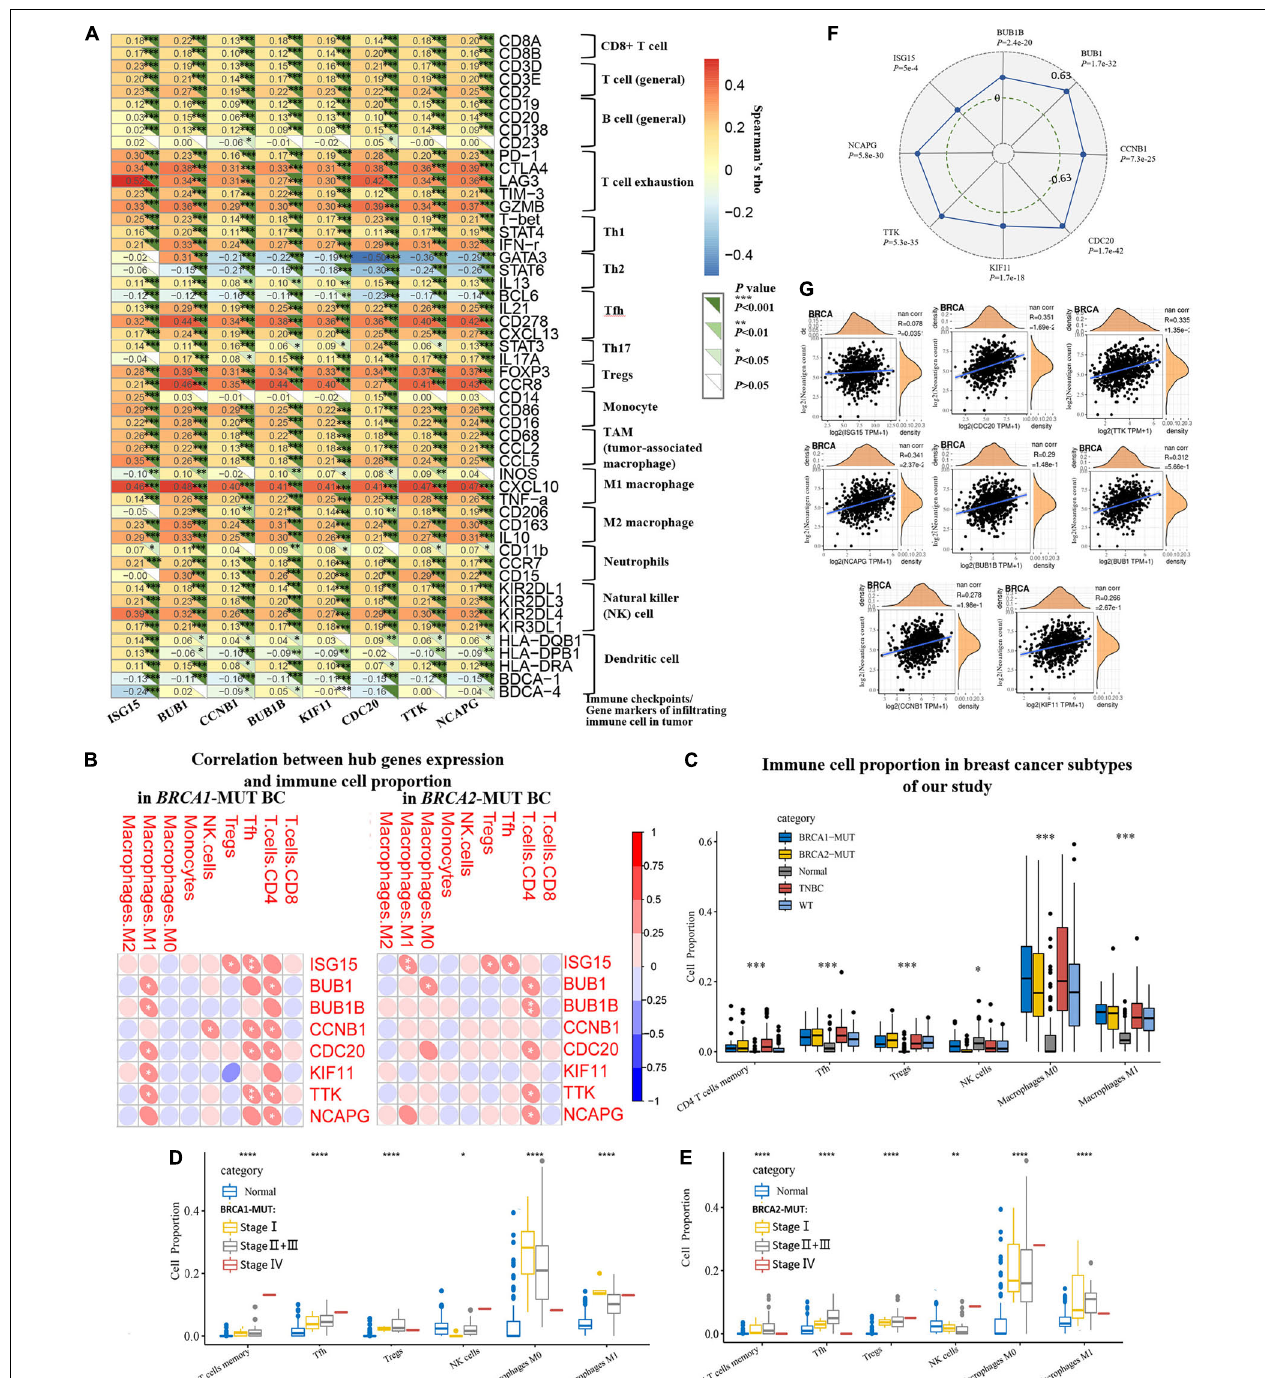
FIGURE 8 | Analysis and identification of BRCA1/2 -MUT-specific immune-associated patterns and their relationships with TMB and neoantigen load in BC. (A) Correlation analysis between related hub genes ( ISG15 , BUB1 , CCNB1 , BUB1B , KIF11 , CDC20 , TTK , and NCAPG ) and immune cell markers in TIMER. Expression scatter plots for pairs of genes adjusted by tumor purity in BC (1093 cases), together with Spearman’s rho value and estimated statistical significance, reflecting the correlations between hub genes and immune checkpoints/gene markers of immune cells. (B) Correlations between hub gene expression and infiltrating immune cell proportions in BRCA1 -MUT and BRCA2 -MUT BC. (C) Infiltrating immune cell proportions (with obvious correlations with hub gene expression in (B) in BRCA1/2 -MUT BC, TNBC, BRCA1/2 -WT BC, and para-cancerous normal tissues, using CIBERSORT package. (D,E) Comparison of immune cell proportion between stages I, and stage II + III and stage IV in BRCA1/2 -MUT BC patients, and para-cancerous normal tissues. (F) Correlations between hub gene expression and TMB in BC. (G) Correlations between hub gene expression and neoantigen load in BC. * P < 0.05, ** P < 0.01, *** P < 0.001, **** P < 0.0001.